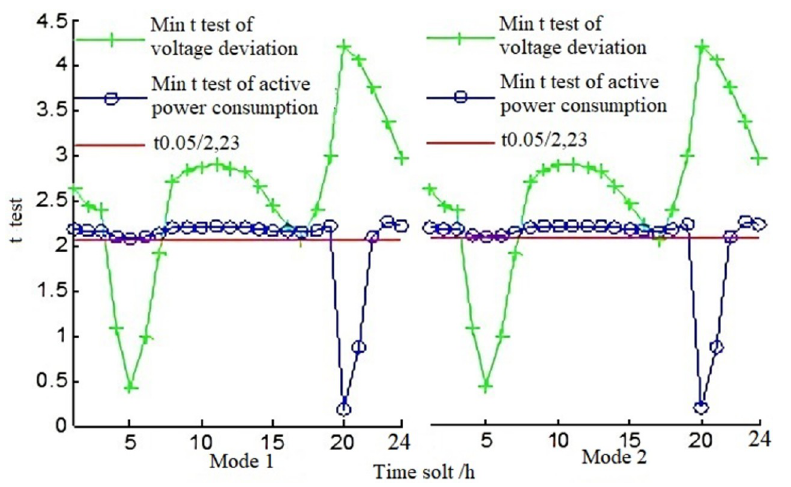
Fig 7. T-test diagram of voltage deviation and active power consumption of IEEE57